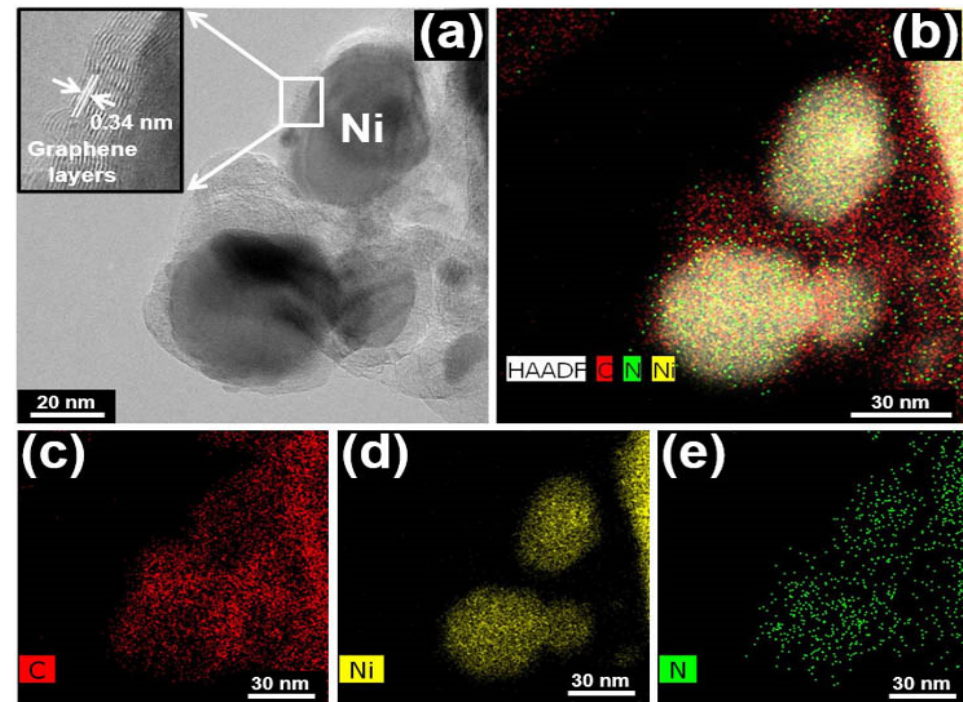
Figure 4. ( a ) High resolution (H-TEM) image, and ( b – e ) elemental mapping of the N-doped Ni- graphene CSNPs for an NH 3 flow amount of 300 sccm.